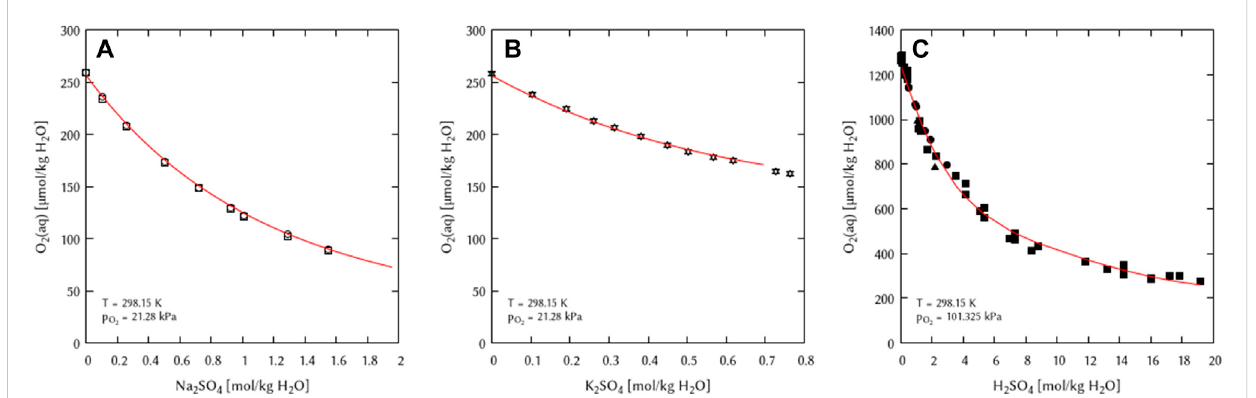
FIGURE 5 Modelling of the O 2 solubility in binary solutions of (A) Na 2 SO 4 , (B) K 2 SO 4 , and (C) H 2 SO 4 as a function of the electrolyte concentration at T = 298.15 K(Points:Experimentaldatafrom: □ Milleroetal.(2002a), ○ Milleroetal.(2002b), n Milleroetal.(2003), ▽ MilleroandHuang(2003), ■ Das(2005), C Geffcken (1904), ▲ Narita et al. (1983), Lines: this work).